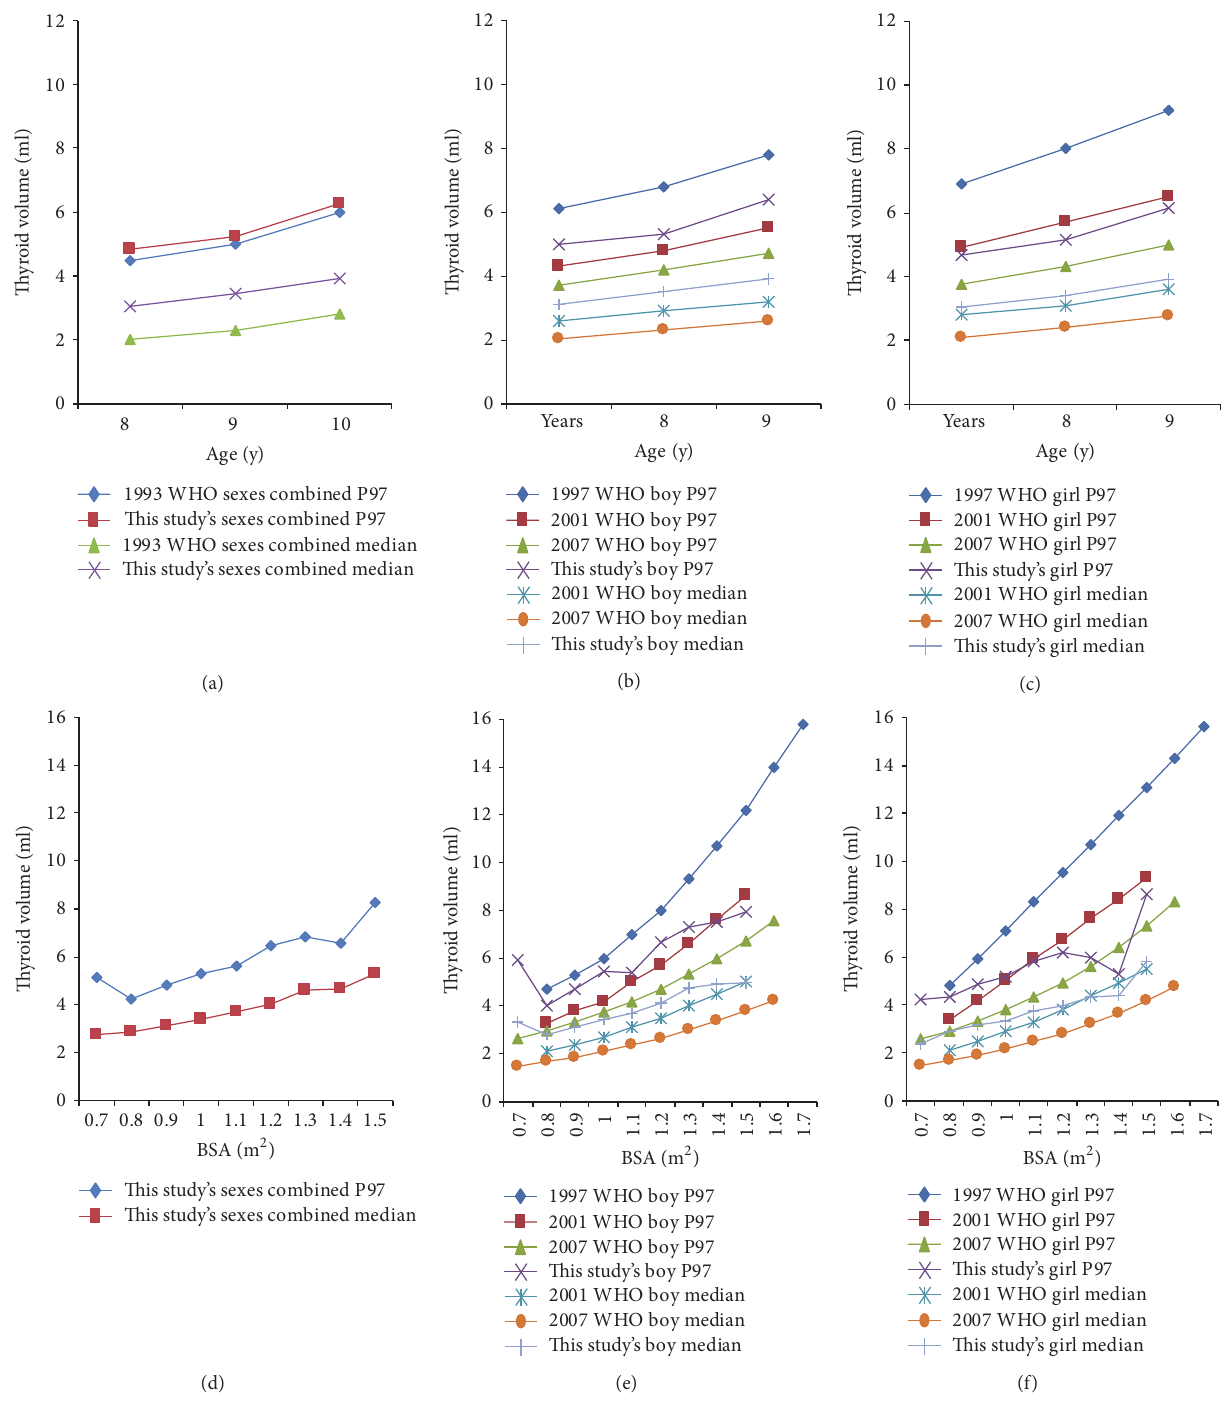
Figure 2: Comparison of median and P97 of thyroid volume between this study and WHO/IGN recommended references by age and BSA. (a), (b), and (c) show reports published from 1993 to 2007 [1, 6, 19, 20]; (d), (e), and (f) show reports published from 1997 to 2007 [1, 6,